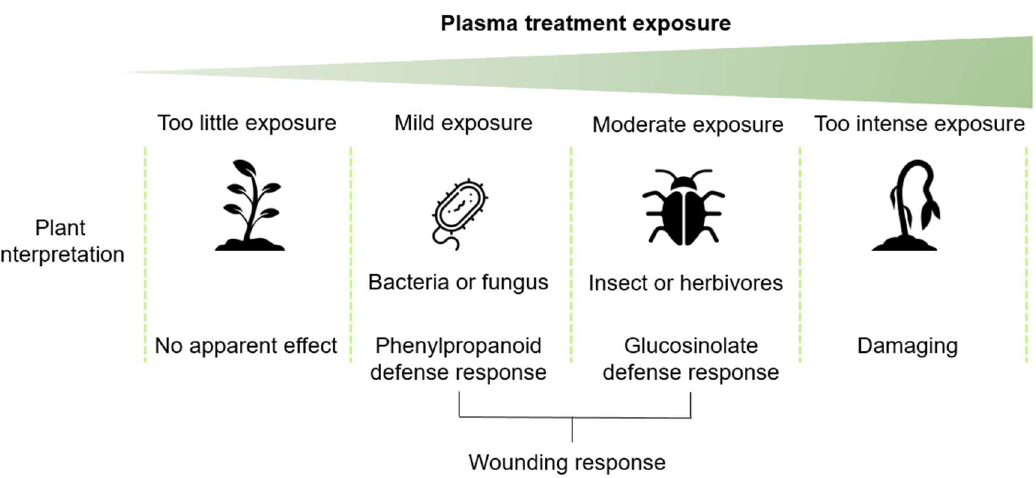
Figure 9. A tentative hypothesis summarizing the findings in this study where 60 s in our study was considered as mild plasma exposure and 80 s as moderate plasma exposure and resulted in phe- nylpropanoid or glucosinolate biosynthesis, respectively. phenylpropanoid or glucosinolate biosynthesis,